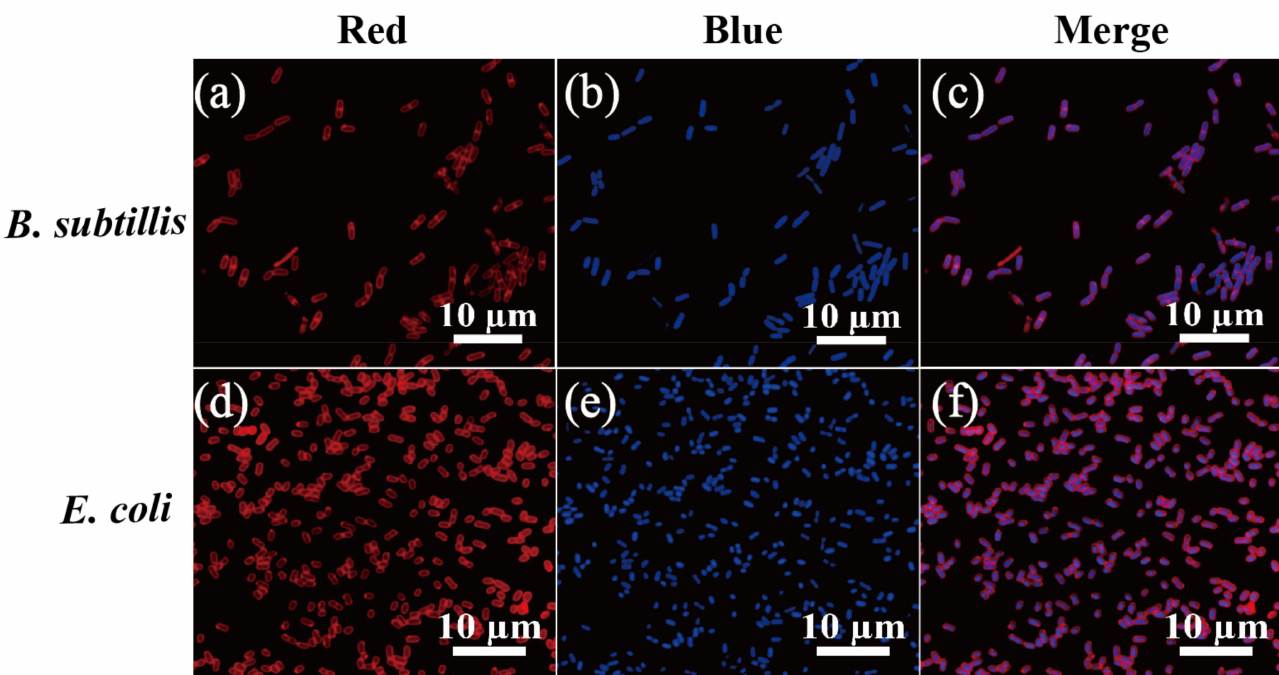
Figure 8. Fluorescence microscopy images of B. subtilis , and E. coli stained with N-CQDs. The cells were stained with 1000 ppm N-CQDs ( a , d ) and DAPI ( b , e ) and merge ( c , f ) fluorescent dye. Red fluorescence was detected under TRITC filter set, whereas DAPI filter detected blue fluorescence. Scale bar represents 10 µ